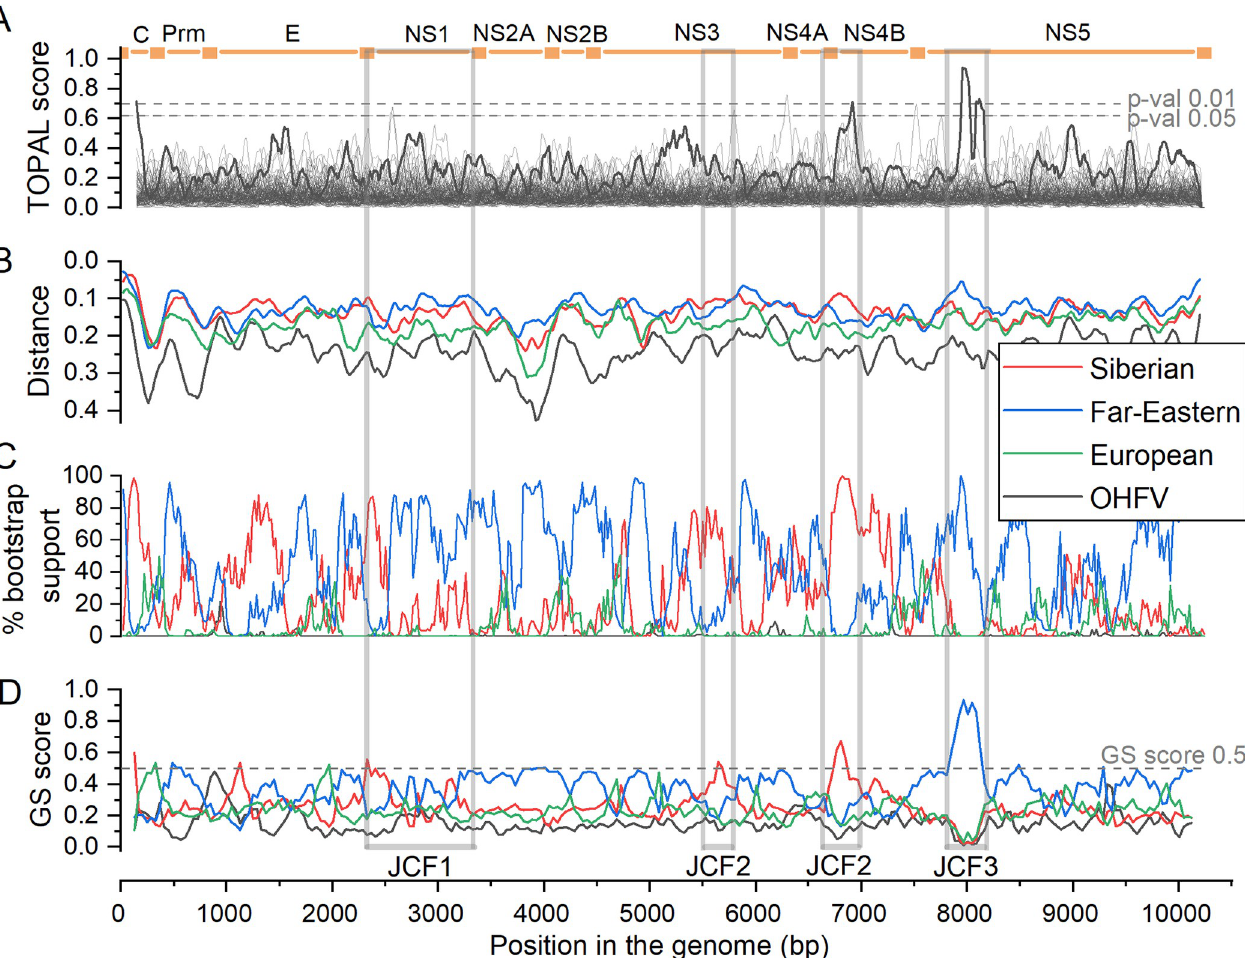
Fig 2. Evidence for recombination at origin of the Baikal subtype. Each analysis compared five consensus sequences: of the Baikal subtype (used as the query), and of the four other subtypes. (A) TOPAL/DSS score, reflecting the difference in shapes of the phylogenies between the adjacent alignment windows (dark gray), against the background of the same values calculated for bootstrap replicates of simulated non-recombinant sequences (light gray); the two dashed lines indicate the expected 99% and 95% confidence intervals of expected scores [36]. (B) SIMPLOT score, reflecting the nucleotide sequence distance between the query and the four consensus sequences [35]; the Far-Eastern subtype is the closest to the Baikal subtype throughout most of the alignment, but the Siberian subtype is more closely related in some of the alignment regions. (C) Bootscan plot is based on reconstructing the neighbor joining trees for each sequence window, and calculating the bootstrap support for the clade uniting the query subtype and each of the four other subtypes [34]; again, the clade uniting the Baikal subtype with the Far-Eastern subtype has the highest support for the bulk of the alignment, but the clade uniting it with the Siberian subtype has a higher support for some regions. (D) GS analysis. Joint characteristic fragments (JCFs) used for subsequent phylogenetic reconstruction are shown below the GS scores plot. The 0.5 threshold is shown as a dashed gray line. For (A)-(C), default parameters were used, namely, sliding window of length 200, step 20 (for (A), step 10 + smoothing step 10). For (D), we used the sliding window length of 250, and step size of 40.